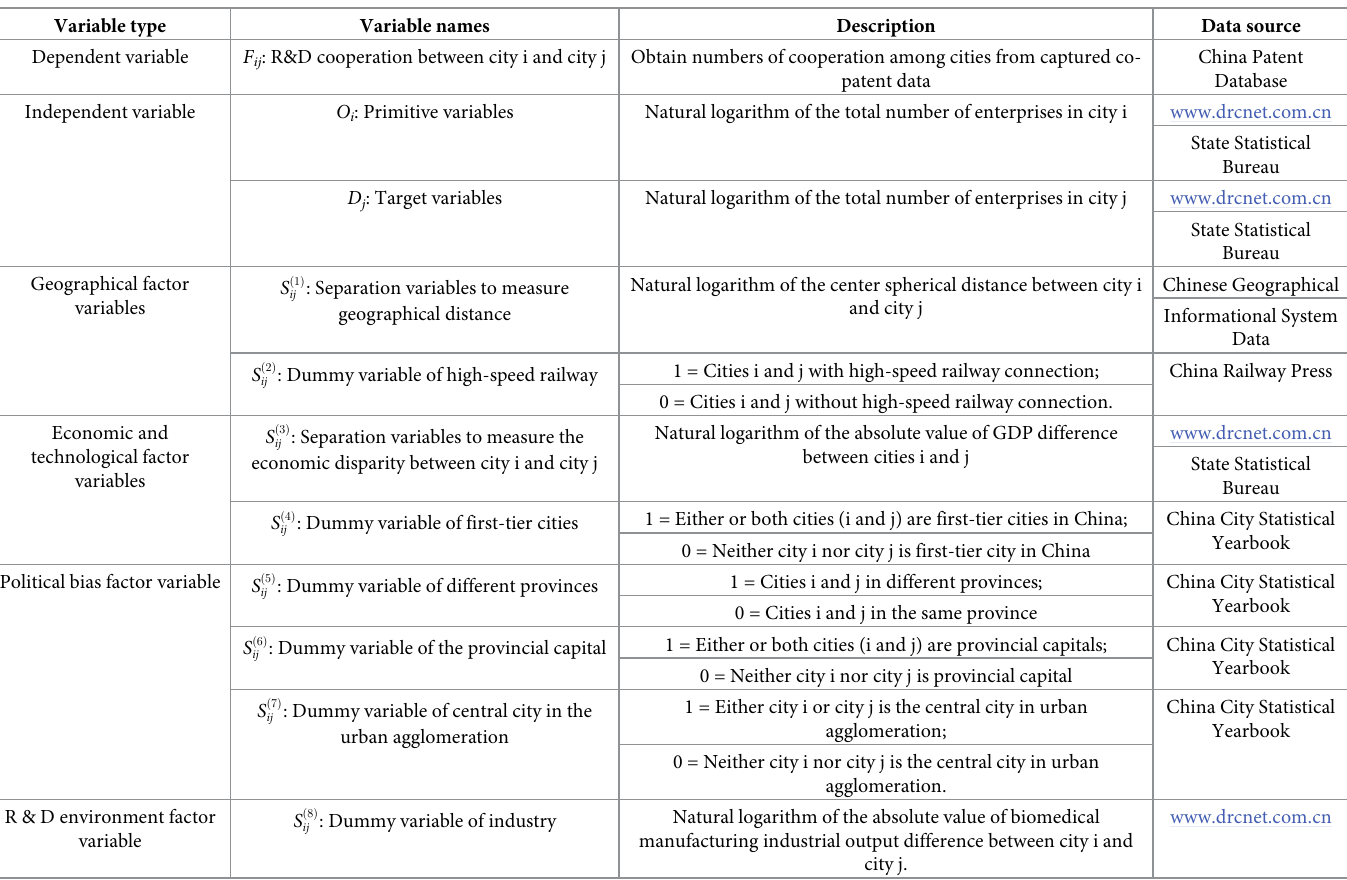
Table 1. Variable description and data sources.